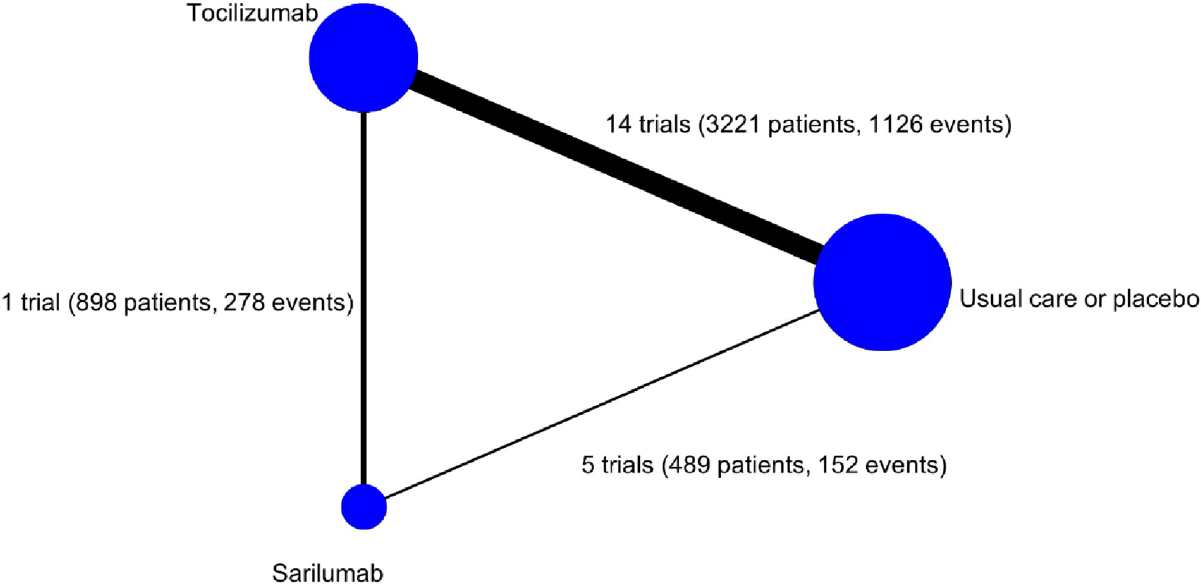
Fig 2. Network map showing numbers of trials in each direct treatment comparison. The node size is proportional to the number of trials that include this treatment. The width of the lines is proportional to the total number of events involved in each direct comparison.